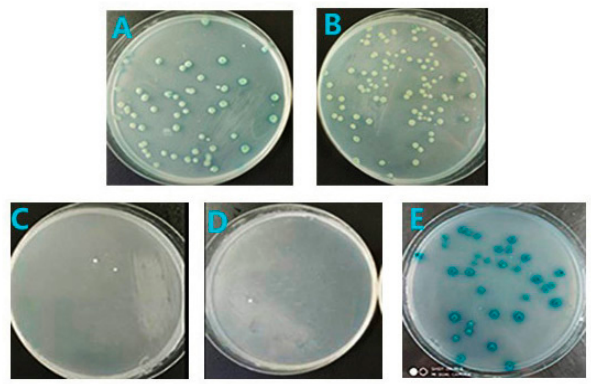
Figure 6. Regressive verification of NS3 and its three domains S7/DEXDc/HELICc with PRDX1: ( A ) full-length NS3 versus duck PRDX1 growing on QDO/X/A, ( B ) full-length NS3 versus human PRDX1 growing on QDO/X/A, ( C ) S7 versus duck PRDX1 growing on QDO/X/A, ( D ) DEXDc versus duck PRDX1 growing on QDO/X/A, and ( E ) HELICc versus duck PRDX1 growing on QDO/X/A.